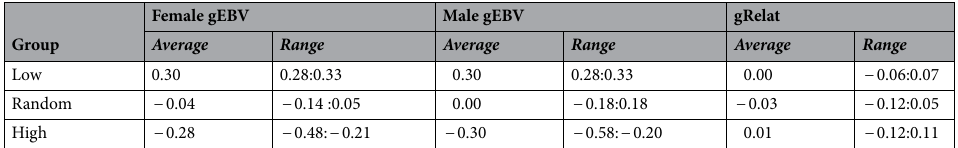
Table 4. Choice of mate pairs used to produce the low, random and high gEBV groups showing average and range in genomic estimated breeding values (gEBV) and genomic relationship values (gRelat) for selected G 0 individuals. Two females in the low gEBV group and two males in the high gEBV group were mated twice to produce